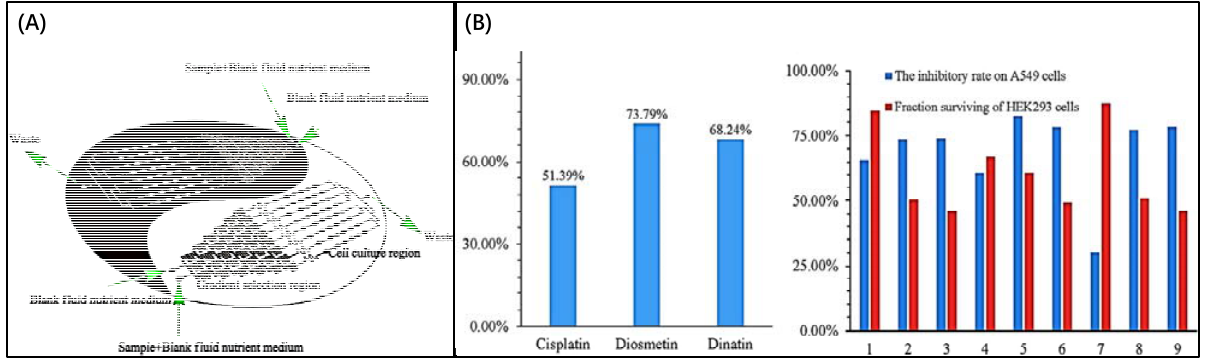
Figure 14. Schematic representation of cisplatin, dinatin, diosmetin activity, and toxicity screening by Microfluidic chip: ( A ) Schematic diagram of the chip. ( B ) The calculated survival rate of cisplatin, dinatin, and diosmetin to HEK293 cell, along with the results of each compatibility group. The image from [16], Copyright 2019, Elsevier.